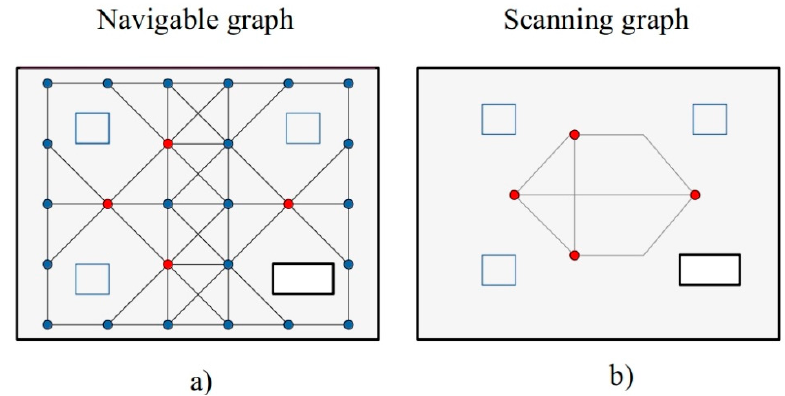
Figure 11. ( a ) A navigable graph composed by navigable (blue) and scanning (red) nodes is generated. Then, navigable nodes are abstracted from graph and ( b ) a simpler one is represented only with scanning nodes (red).